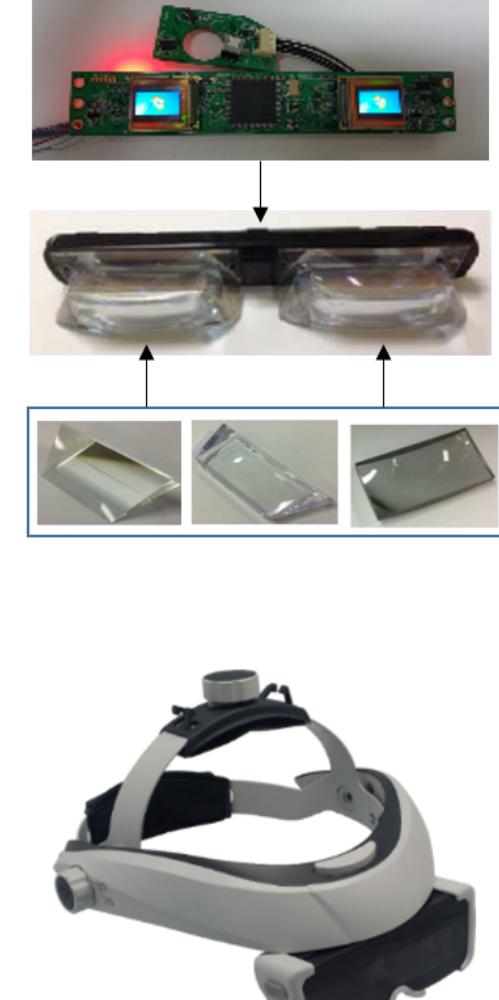
Figure 3. Top left: optical design of see-through type 3D head-mounted display (HMD); top right: integration of the control board and the optical module; bottom left: headband design; bottom right: fabricated see-through type 3D HMD.